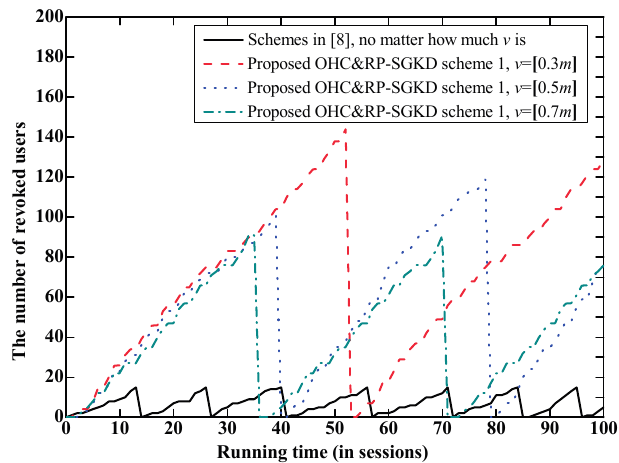
Figure 3. The possible lifetime in 100